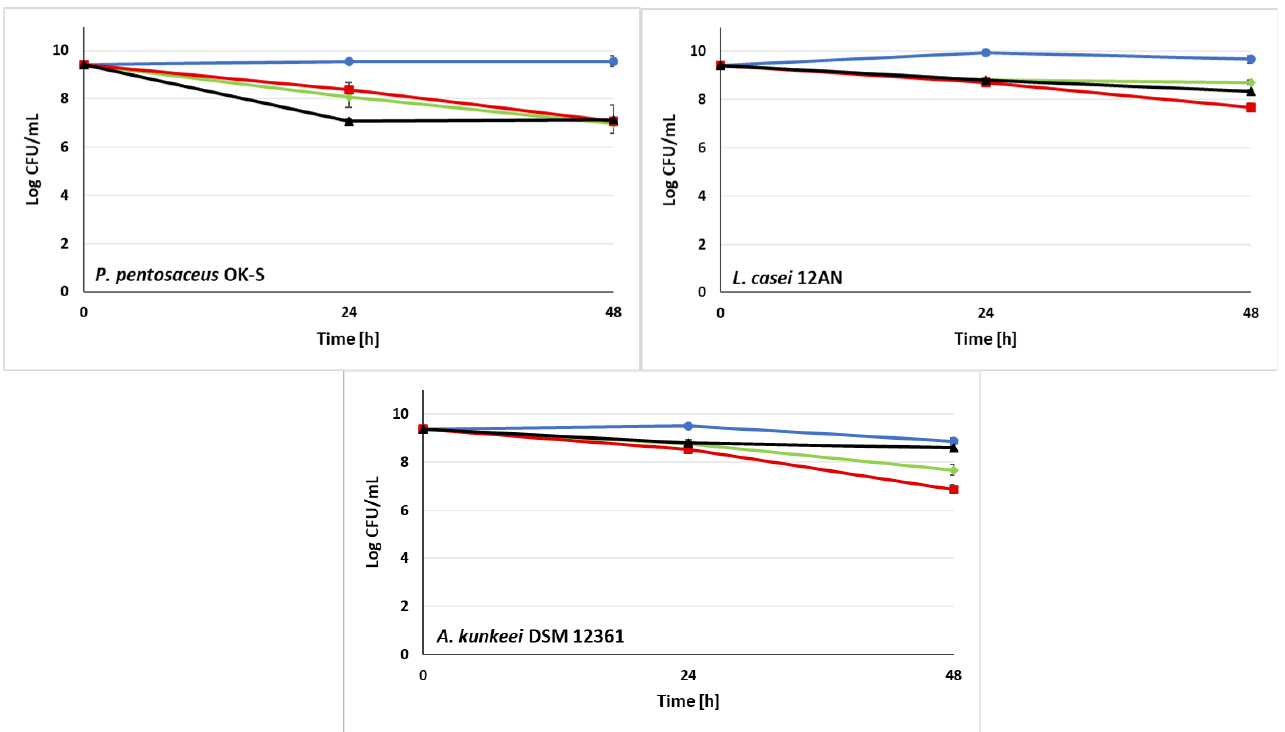
Figure 3. Survival of lactic acid bacteria (LAB) strains in sugar syrups A, B, and C after 24 and 48 h of incubation. The color of the line indicates the incubation conditions of LAB. Blue (circular markers)—no sugar syrup (control); green (diamond markers)—syrup A (40% glucose, 30% fructose, pH 4.2, distilled water); red (square markers)—syrup B (30% glucose, 40% fructose, 30% saccharose, distilled water); and black (triangular markers)—syrup C (50% saccharose, distilled water). Results are presented as true mean ± standard deviation.